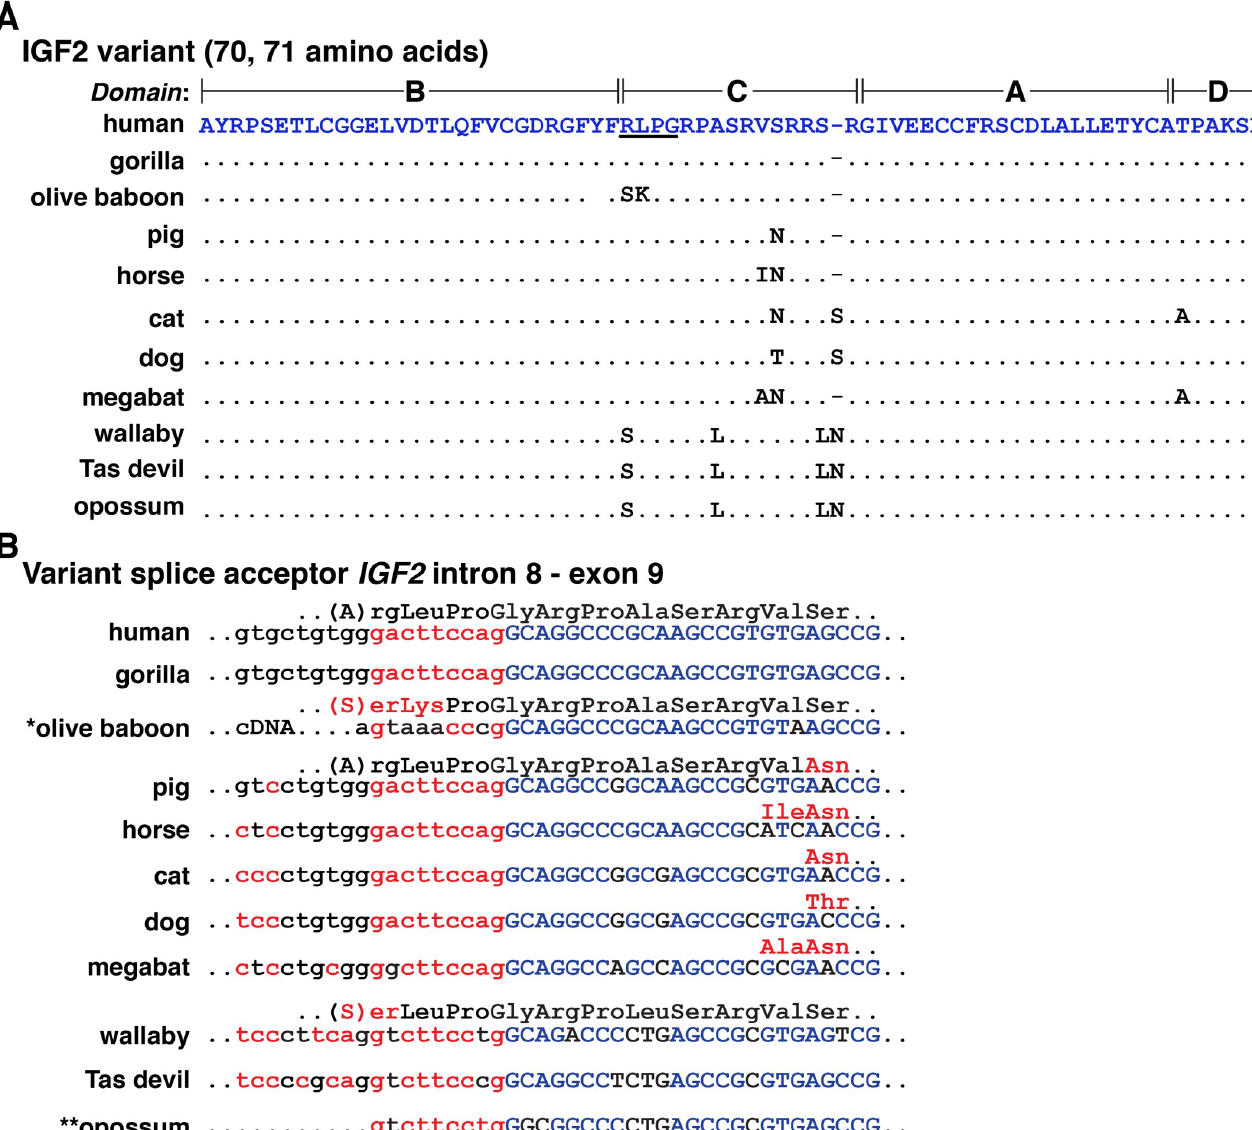
Fig 7. Mechanisms accounting for variant IGF2 proteins. A . Amino acid sequences of a mammalian IGF2 variants with 70 or 71 amino acids are depicted in single letter code. The additional residues are underlined for human IGF2. Dots depict identities, and differences among species are indicated. A dash depicts no residue. B . The molecular basis for 70- or 71-amino acid IGF2 is a consequence of alternative splicing into the equivalent of human IGF2 exon 9, which adds an additional 9 nucleotides (in lower case and in red) to the 5’ end of the exon, and changes a serine codon into arginine-leucine-proline-glycine codons in IGF2 transcripts in human, gorilla, and macaque. In olive baboon, as based on a cDNA sequence deposited in GenBank, a different 5’ end of exon 9 has been proposed, which results in predicted serine-lysine-proline-glycine codons. This sequence cannot be identified at the 3’ end of IGF2 intron 8 in the olive baboon genome (as signified by � ). In pig, horse, cat, dog, and megabat, different amino acids are found in the further COOH-terminal part of IGF2, as indicated in red. In wallaby and Tasmanian (Tas) devil, serine-leucine-proline-glycine comprise the variant amino acid quartet. This also may be true for opossum, but the relevant genomic DNA sequence is not available (thus ��